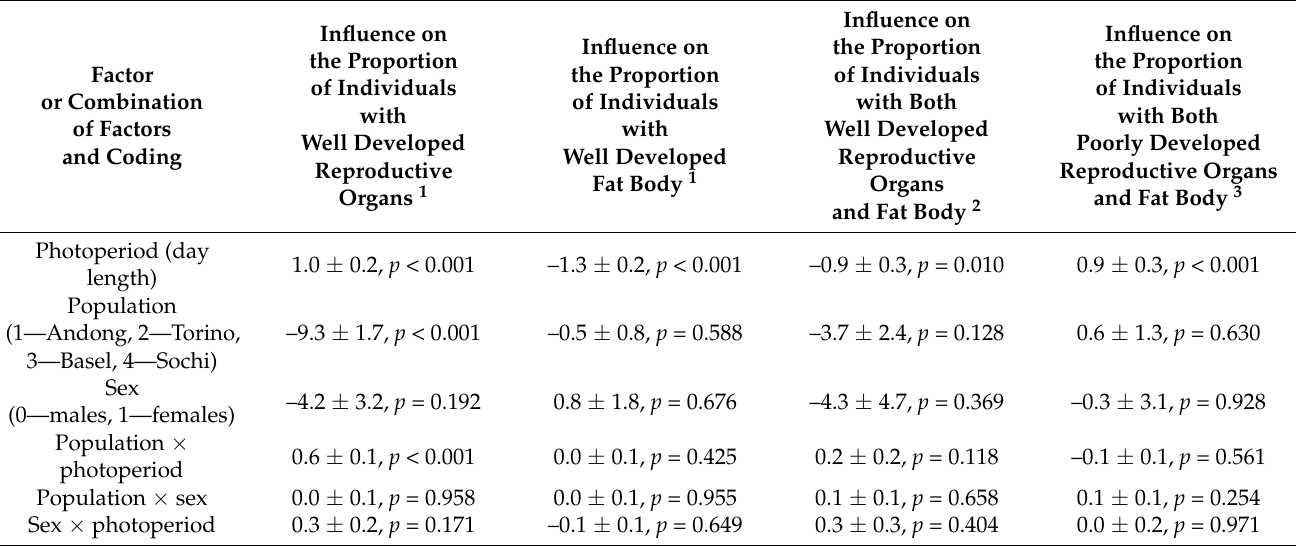
Table 2. Photoperiodic effects on the development of reproductive organs and fat bodies in Halyomor- pha halys males and females from four different populations (Binary probit analysis (0—no, 1—yes): regression coefficient C ± SE and significance ( p ) of